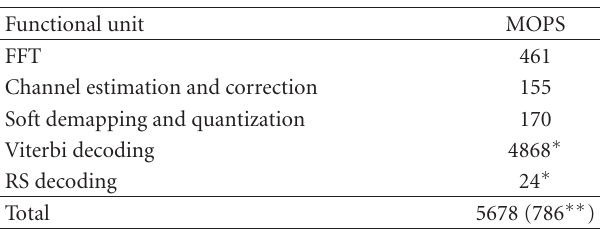
Table 2: Computational